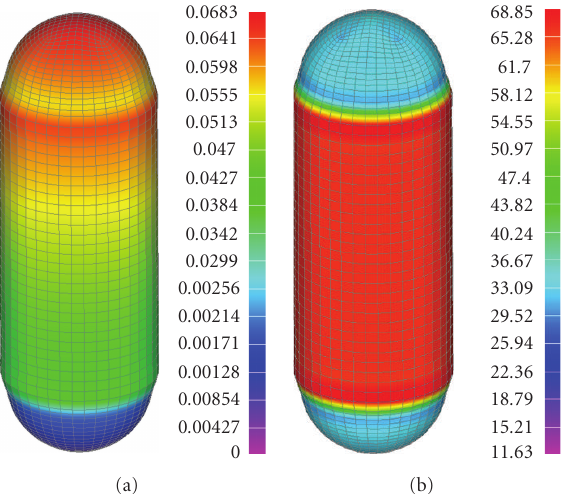
Figure 8: (a) Deformations and displacements. (b) Principal maximum stresses at the outer surface. The stresses are obtained with wall